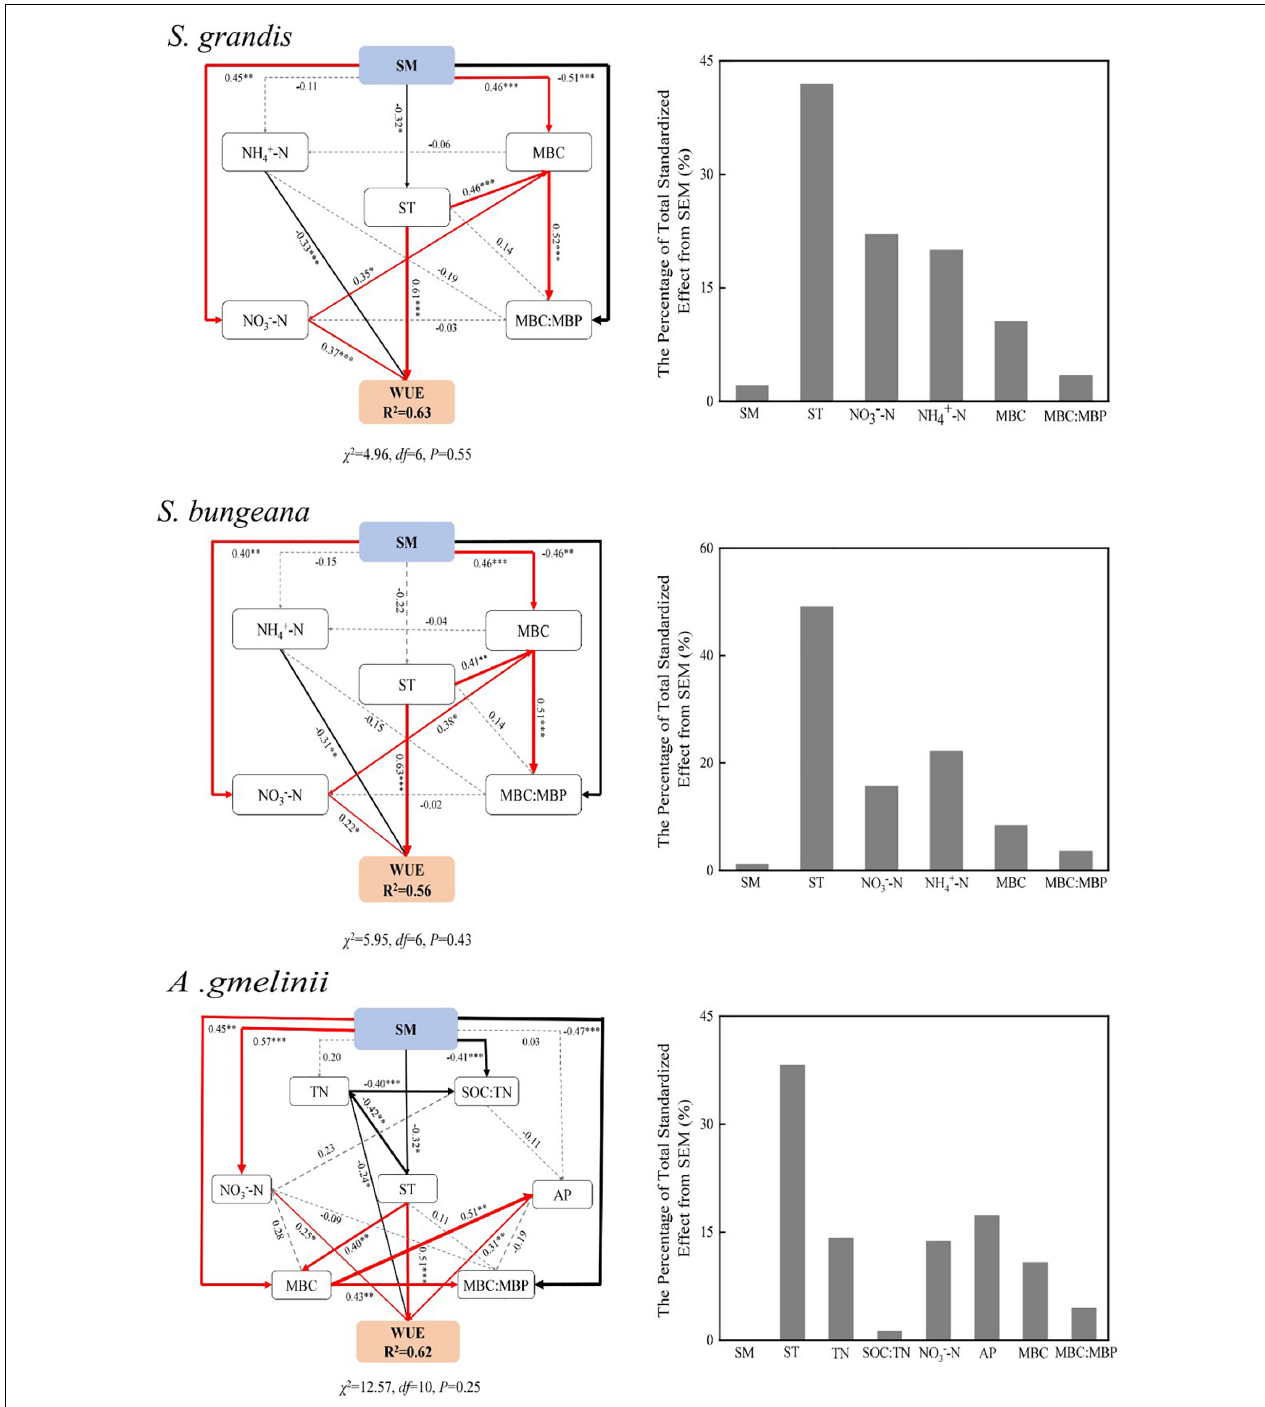
FIGURE 4 | Structural equation model of the effect of soil properties and microbial biomass ecological stoichiometry on WUE with precipitation manipulation. SM, soil moisture; ST, soil temperature; TN, soil total nitrogen; SOC:TN, soil organic carbon: soil total nitrogen; NH 4 + –N, soil NH 4 + –N content; NO 3 - –N, soil NO 3 - –N content; AP, soil available phosphorus content; MBC, microbial biomass carbon; MBN, microbial biomass nitrogen; MBP, microbial biomass phosphorus; MBC:MBN, MBC:MBN ratio; MBC:MBP, microbial biomass carbon: microbial biomass phosphorus ratio. The final model fit the data well: S. grandis ( χ 2 = 4.96, df = 6, P = 0.55); S. bungeana ( χ 2 = 5.95, df = 6, P = 0.43); A. gmelinii ( χ 2 = 12.57, df = 10, P = 0.25). Numbers at arrows are standardized path coefficients. Width of the arrows indicates the strength of the relationships. The red lines indicate positive and significant, the black lines indicate negative significant, and the dashed lines indicate insignificant, respectively; R 2 values indicate the proportion of the variance explained for each endogenous variable; result for goodness-of-fit tests are also reported underneath each plot ( P > 0.05 indicates a good fit); * P < 0.05; ** P < 0.01; *** P < 0.001.